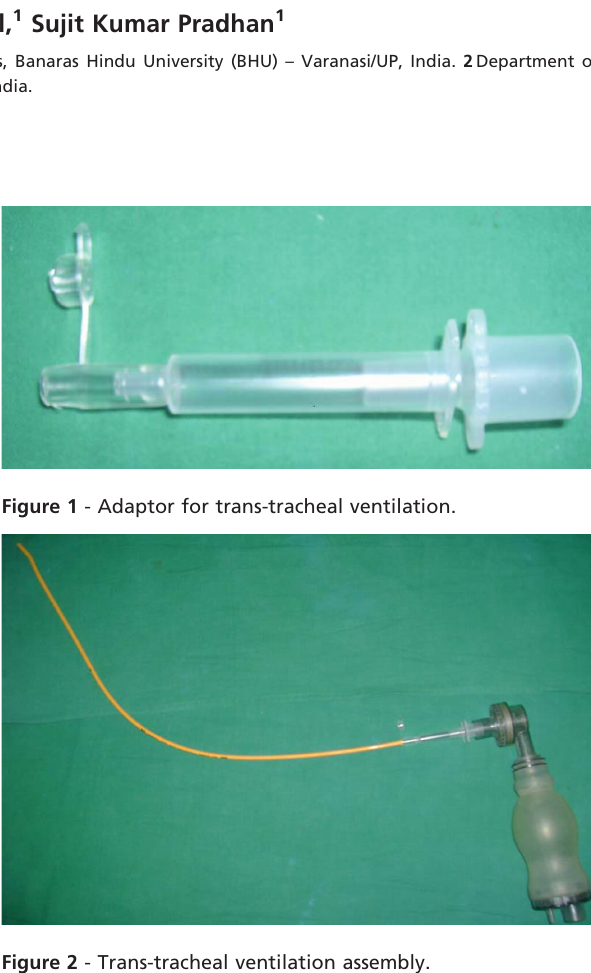
Figure 2 - Trans-tracheal